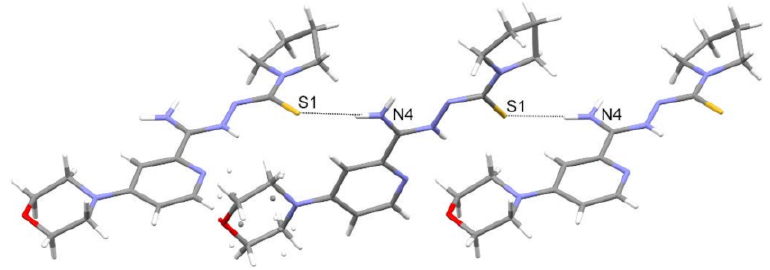
Figure 6. The intermolecular hydrogen bonds in compound 3 . In the structure of compound 4 , there are two molecules of the compound, two molecules of water and two molecules of DMF (one disordered), in the independent part of the unit cell. The molecules have different positions of substituents in the piper- azine ring (equatorial–equatorial or equatorial–axial), with the phenyl always in the equatorial position. This compound also forms chains of hydrogen-bonded molecules with the water molecules as “bridges” (Table 6, Figure 7). The DMF molecules fill the gaps and form hydrogen bonds of the N-H ··· O type (Figure 8). The molecule fragment ( N ’-thioformylpicolinohydrazonamide) takes a flat form (r.m.s. deviation = 0.0655 and 0.0830